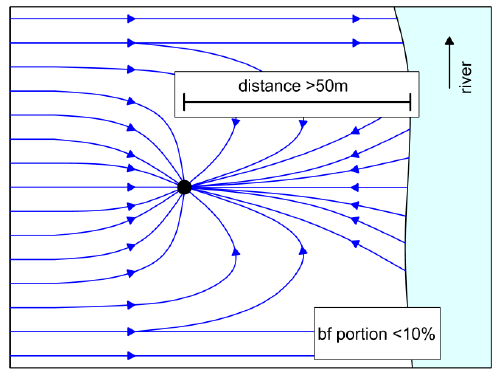
Figure 14. Well placed too far from riverbank pumping less than 10% bank filtrate (bf).